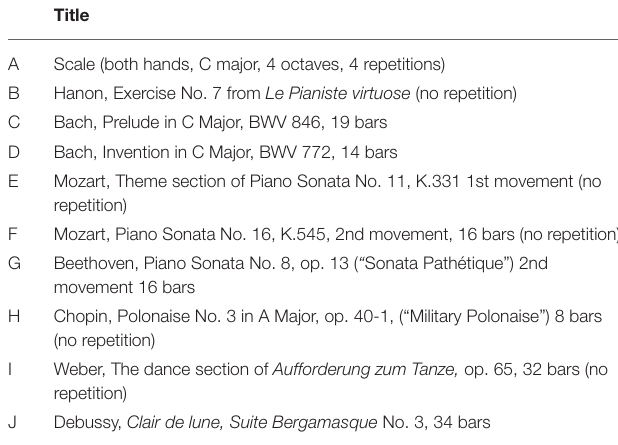
TABLE 1 | Music used in the